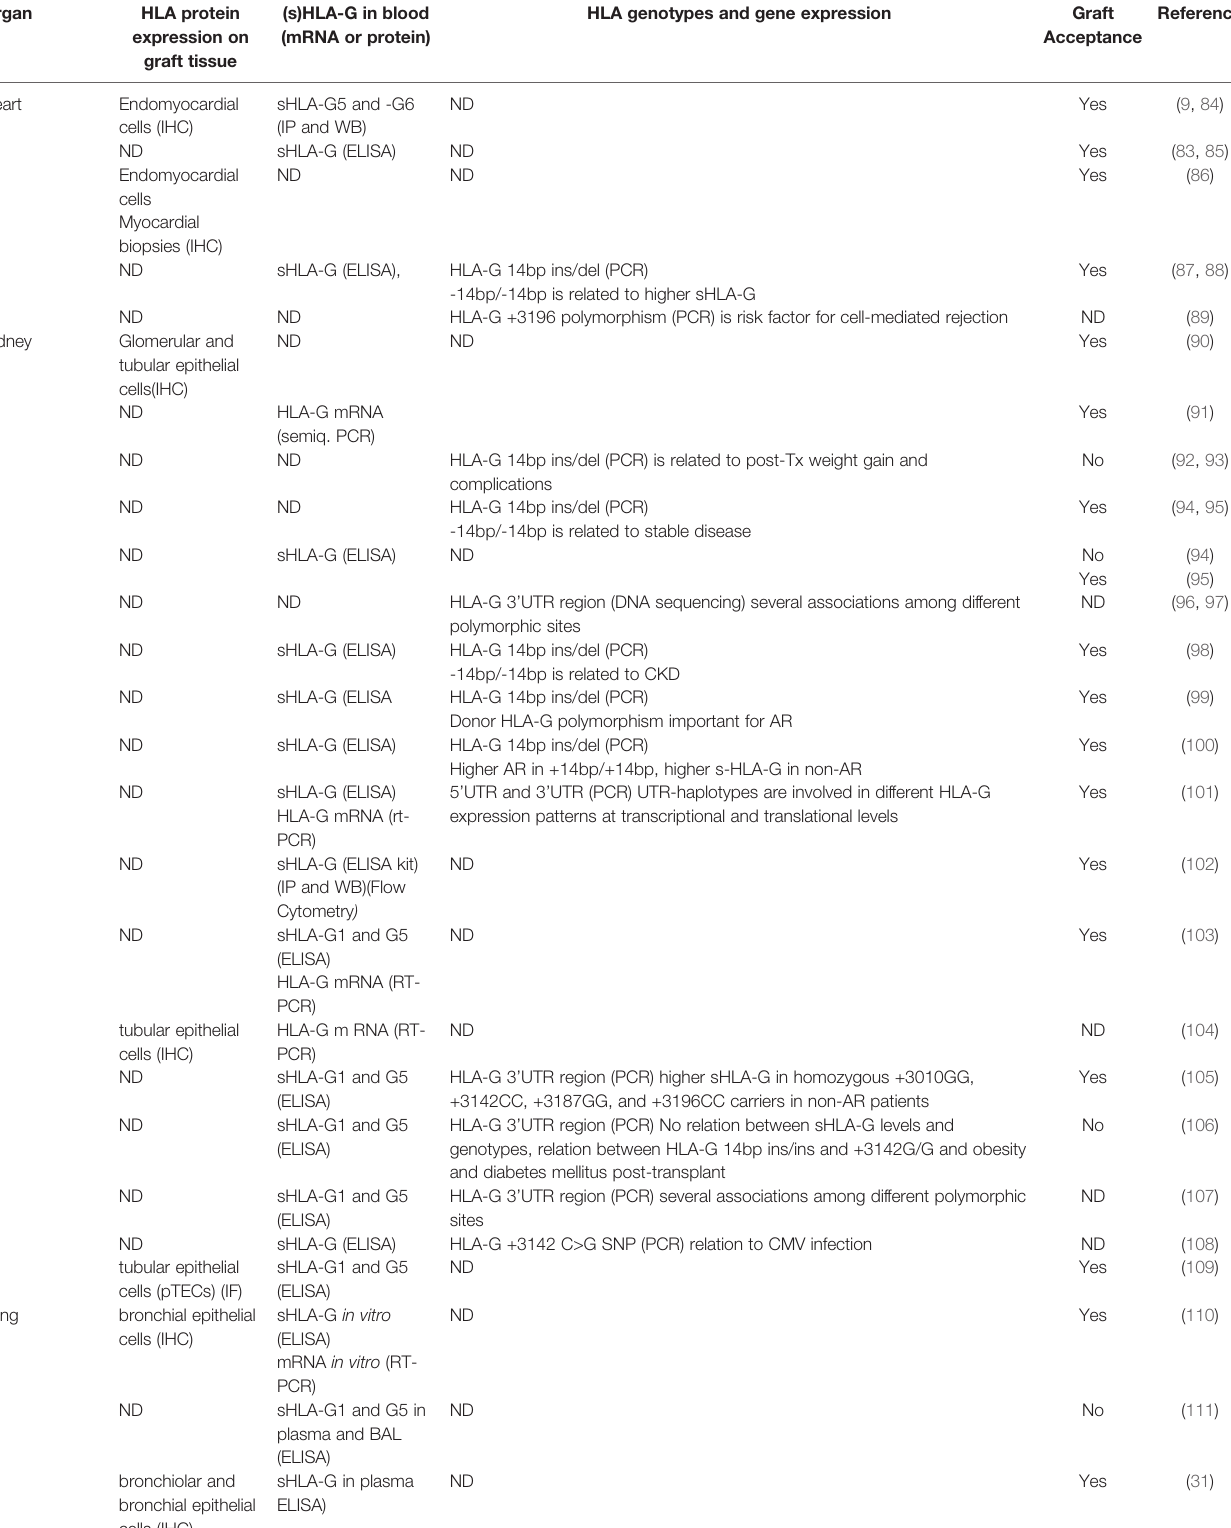
TABLE 1 | The association between HLA-G expression and organ transplantation graft acceptance in clinical studies. Organ HLA protein expression